Question: Does the plotted quantity increase or decrease?
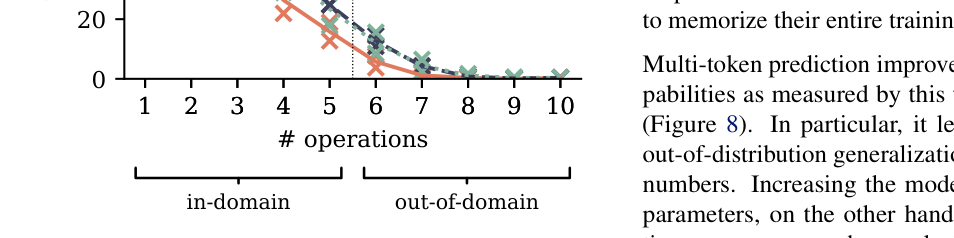
Answer: increasing